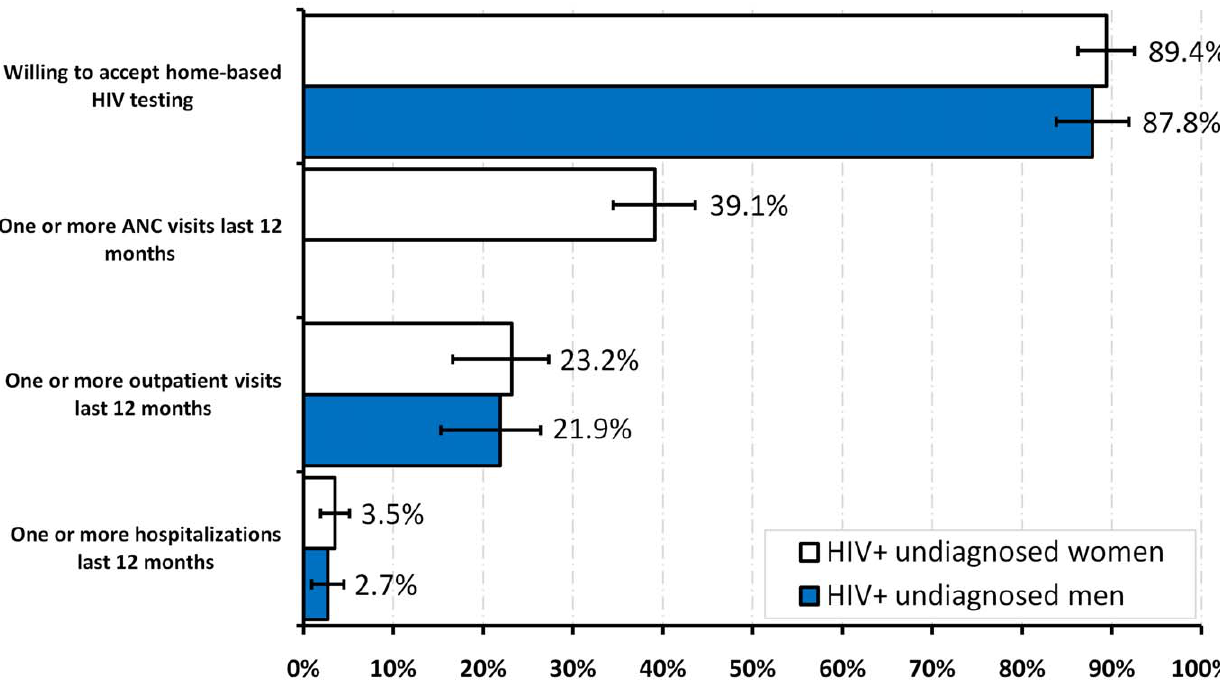
Figure 2. Percentages and 95% confidence intervals of missed opportunities for HIV testing among ever sexually active, HIV- infected undiagnosed persons aged 15–64 years who reported never having been tested for HIV, by gender, Kenya AIDS Indicator Survey 2007.